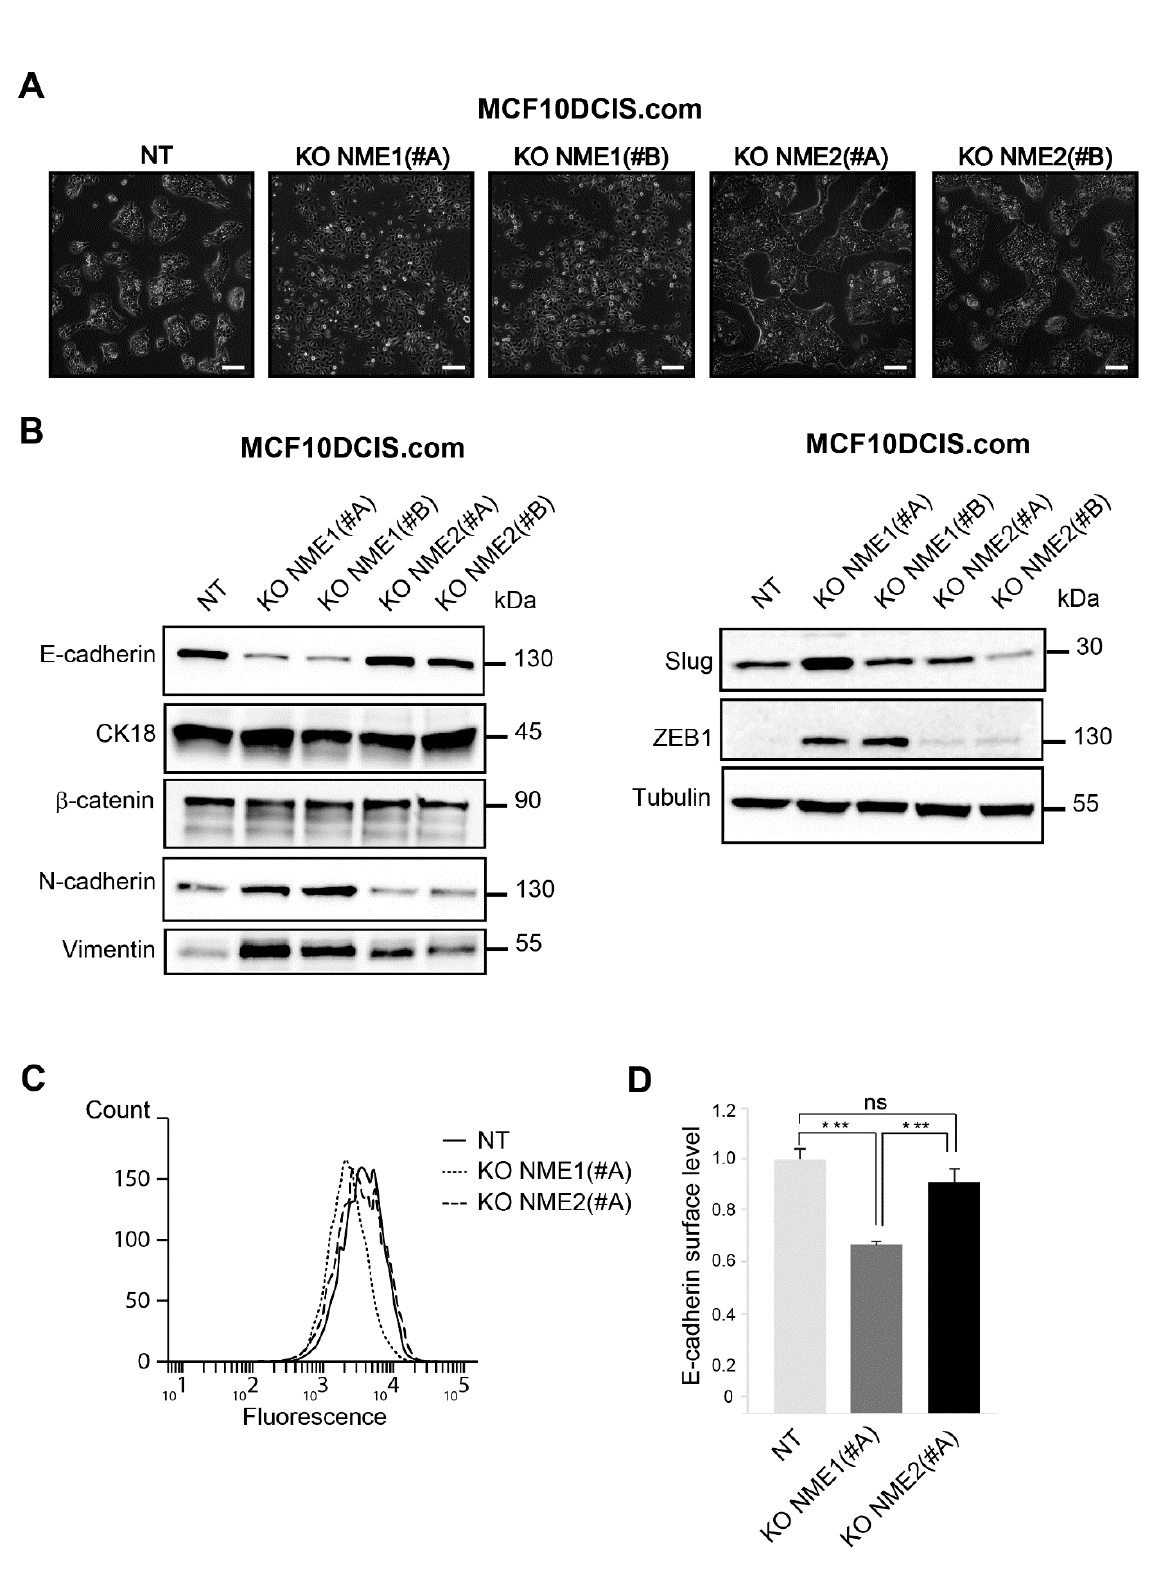
Figure 2. Inactivation of NME1 by CRISPR–Cas9 gene editing reinforces EMT. ( A ) Phase-contrast microscopy of control non-targeting (NT) and NME1 or NME2 knockout (KO) MCF10DCIS.com treated with two different guide RNAs (#A and #B) for each gene, as indicated. Scale bar, 50 µm. ( B ) Lysates of NT and KO cells were analyzed by Western blotting with antibodies against the indicated proteins. Equal loading was verified by Western blotting for tubulin. Molecular weights are indicated in kDa. ( C ) NT and KO cells were analyzed by FACS for cell surface E-cadherin levels. ( D ) Quantification of FACS analysis as in ( C ). Three independent experiments were performed. Data are expressed as means ± SEM. *** p < 0.001, ns: not significant.